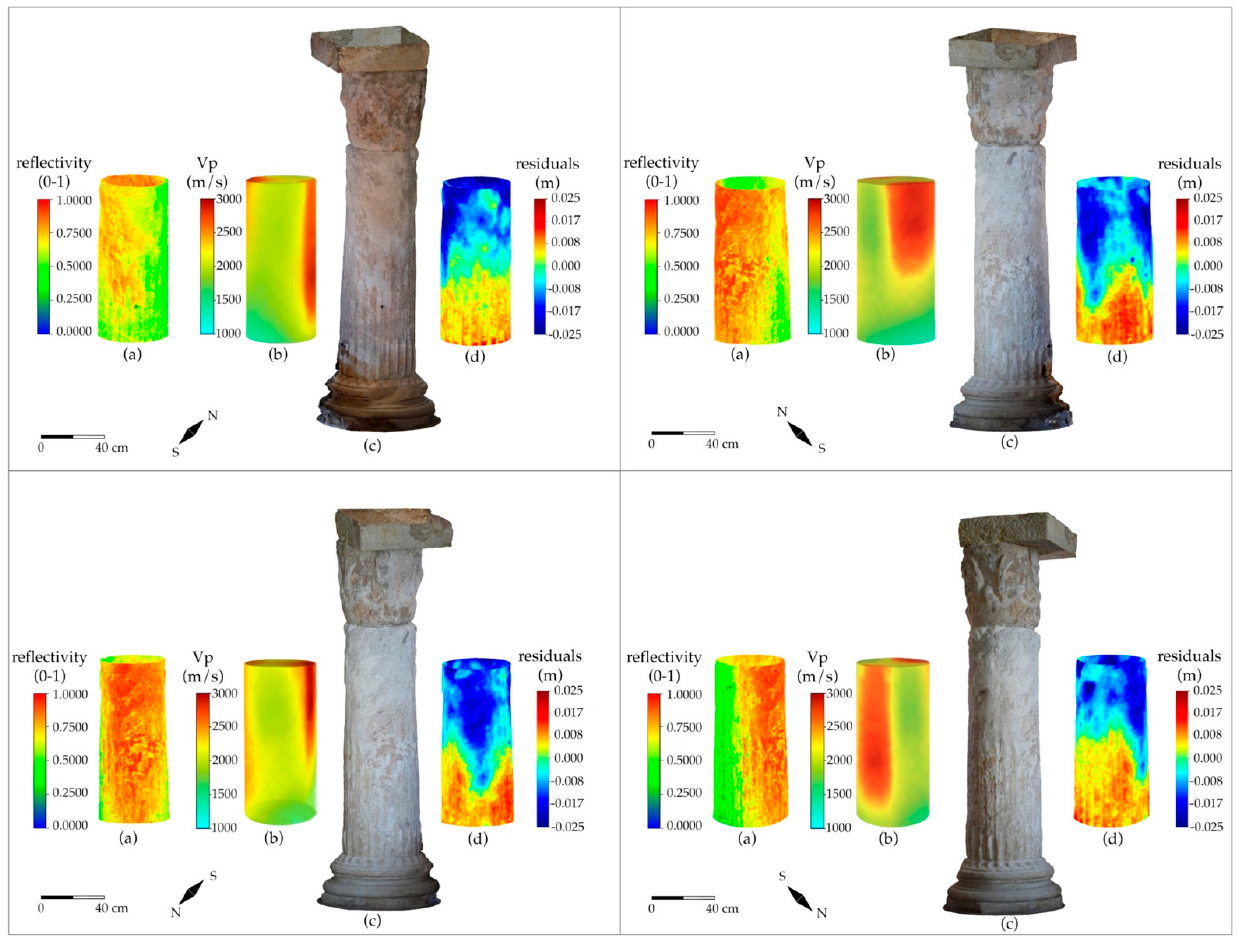
Figure 7. Different views of the 3D high resolution models of the investigated artifact. ( a ) CRP reflectivity model; ( b ) ultrasonic velocity model; ( c ) CRP model of the column; ( d ) geometrical anomalies.